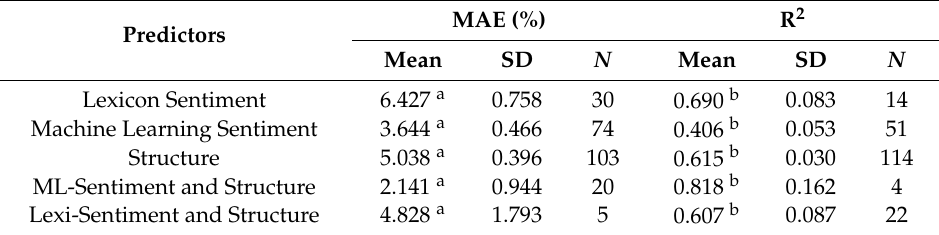
Table 1. Covariate-adjusted means of structure, lexicon, machine learning, and combination